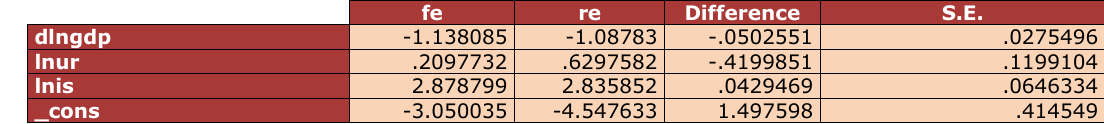
Table 5. Hausman test of panel model of Guangdong province